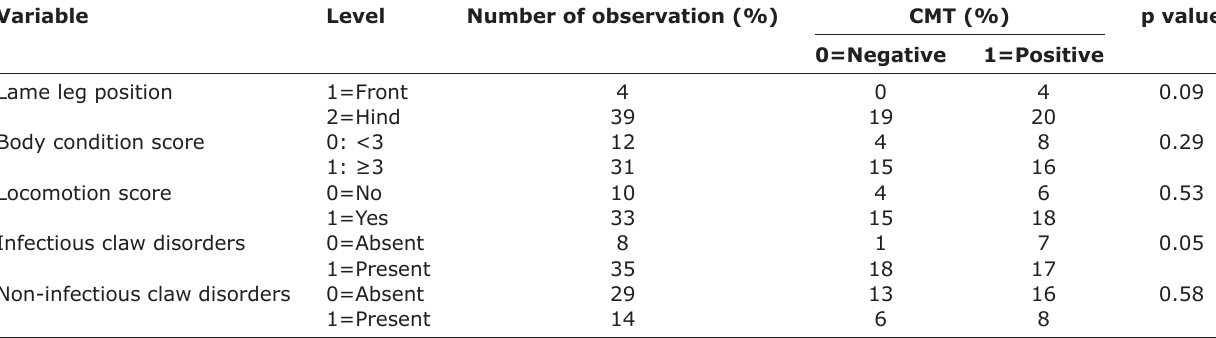
Table-4: Association between potential risk factors and subclinical IMIs diagnosed by CMT in Egyptian dairy cows. Variable